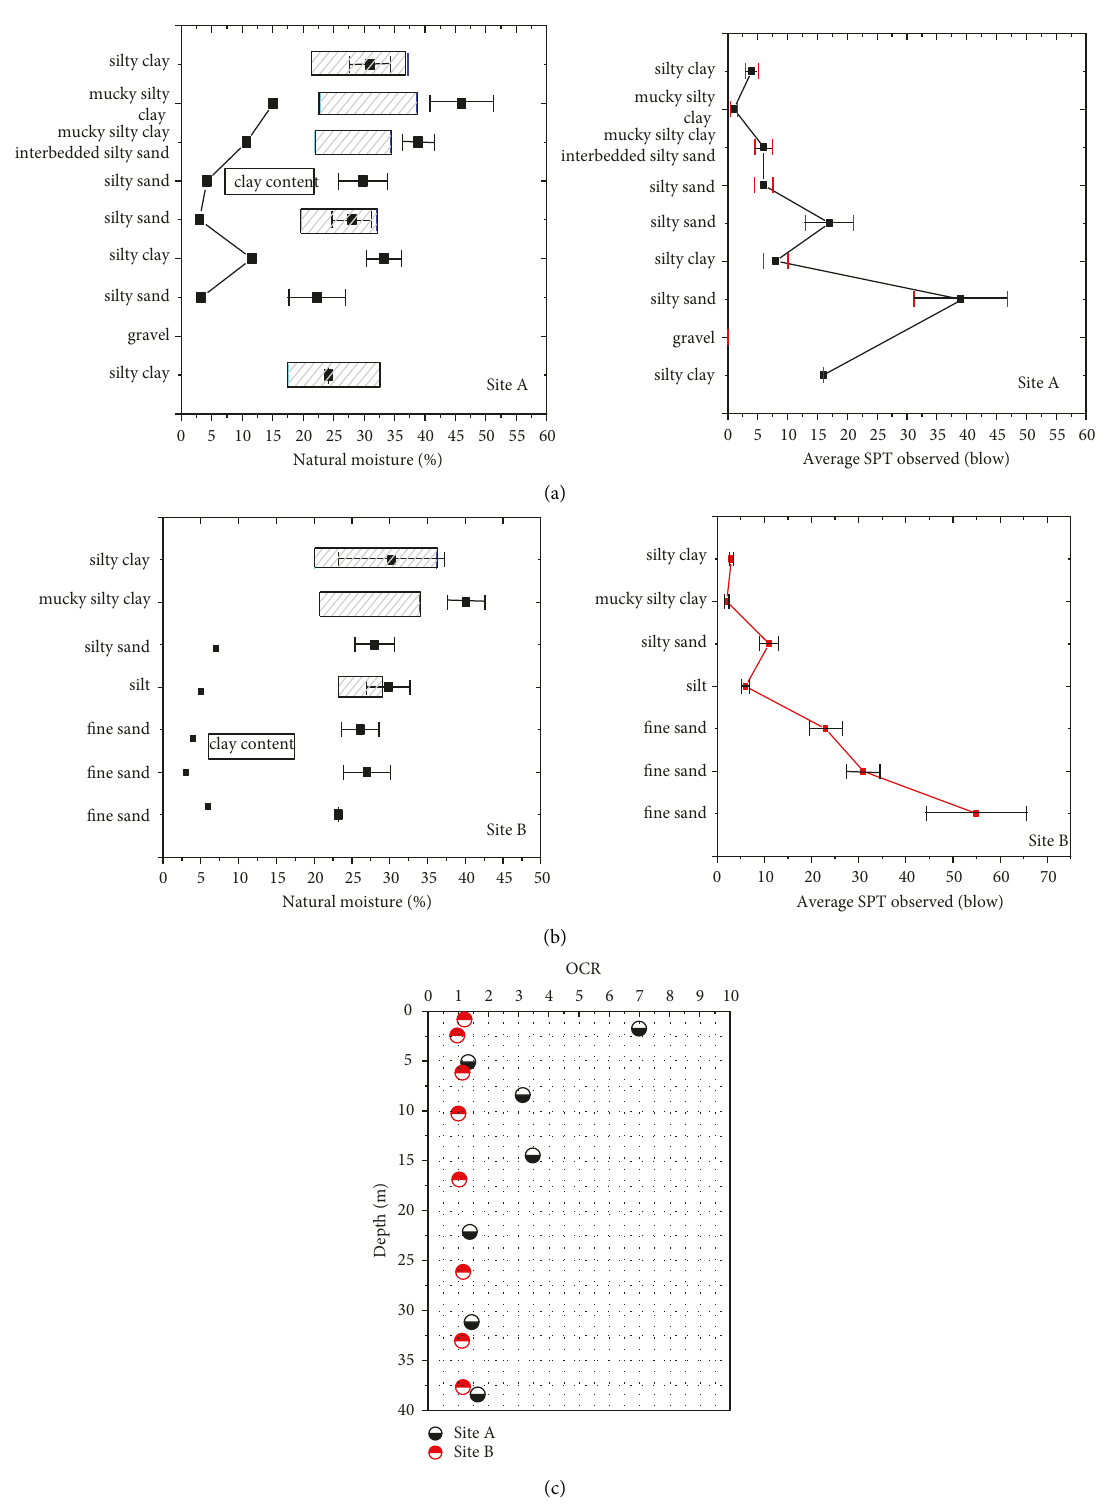
Figure 2: Summary of soil indexes. (a) Average index properties: natural water content, void ratio, Atterberg limits, and percent fines content; (b) average SPT observed; (c) overconsolidation